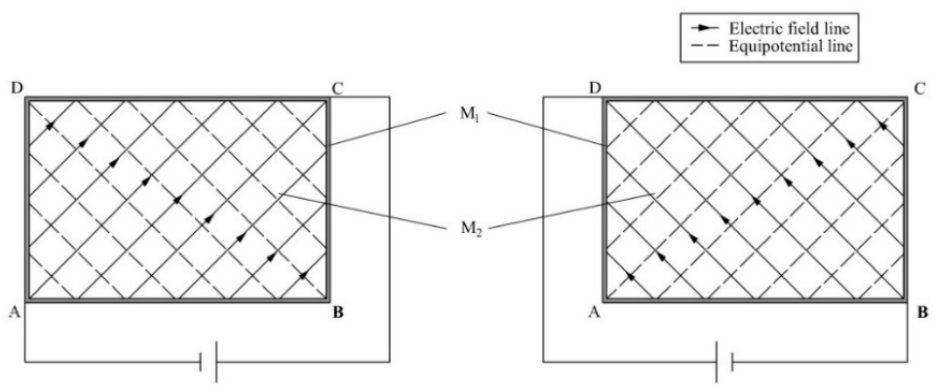
Figure 4. The distribution of the electric field and potential in M 2 of L 1 .